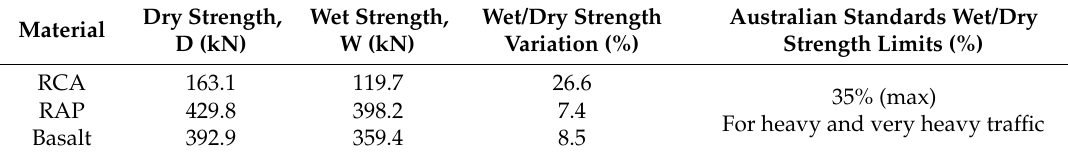
Figure 10. Results of Wet/Dry Strength Test for Coarse Aggregate (Wet Strength). Table 8. The Results of Wet/Dry Strength Variation Test for Aggregates and Strength Limits for Dense Graded Asphalt Based on Australian Standards.